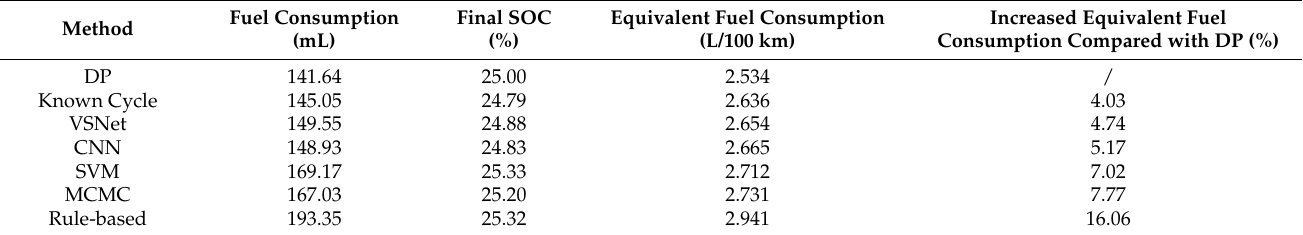
Figure 19. The equivalent fuel consumption for the simulations with different energy management strategies. Table 3. Simulation results.